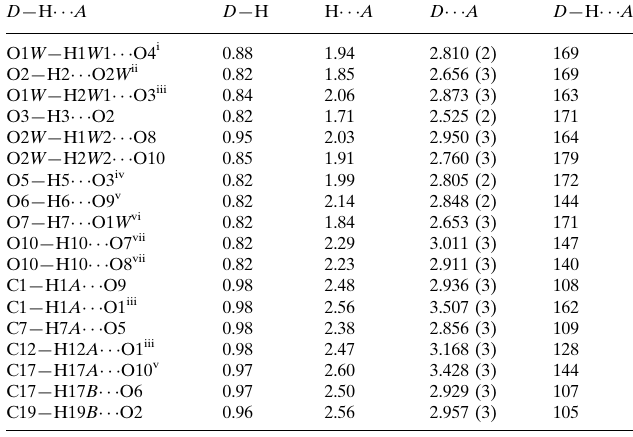
Data collection Bruker SMART APEXII CCD area-detector diffractometer Absorption correction: multi-scan ( SADABS ; Bruker, 2005) T min = 0.950, T max = 0.987 Refinement